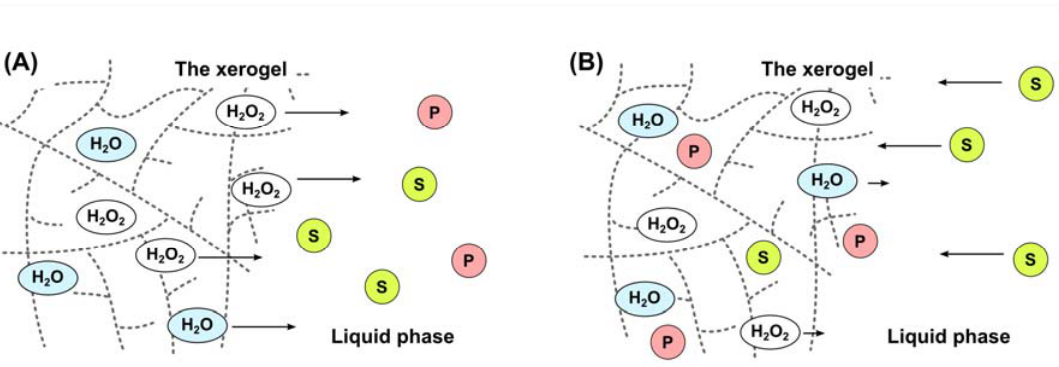
Figure 3. Proposed mechanisms for the xerogel mediated oxidation: S → P. S: